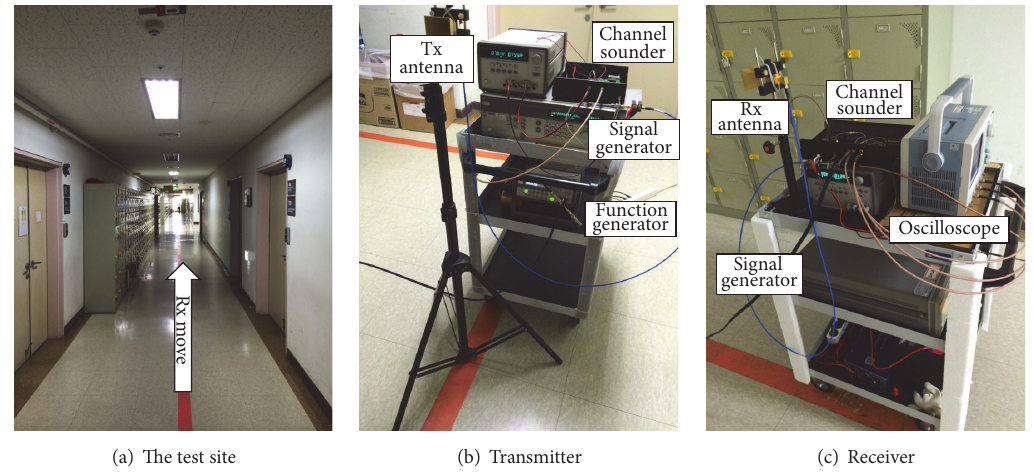
Figure 3: The test site and the measurement